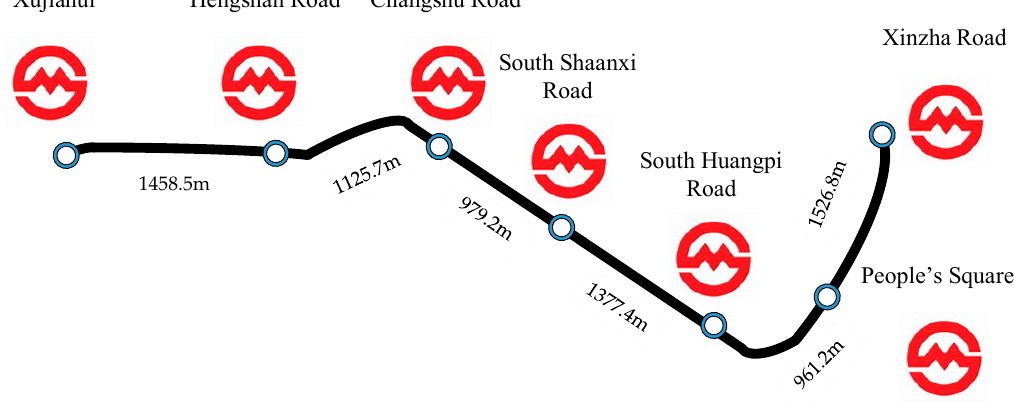
Figure 6. Metro segments of the SML1 for the experiments.